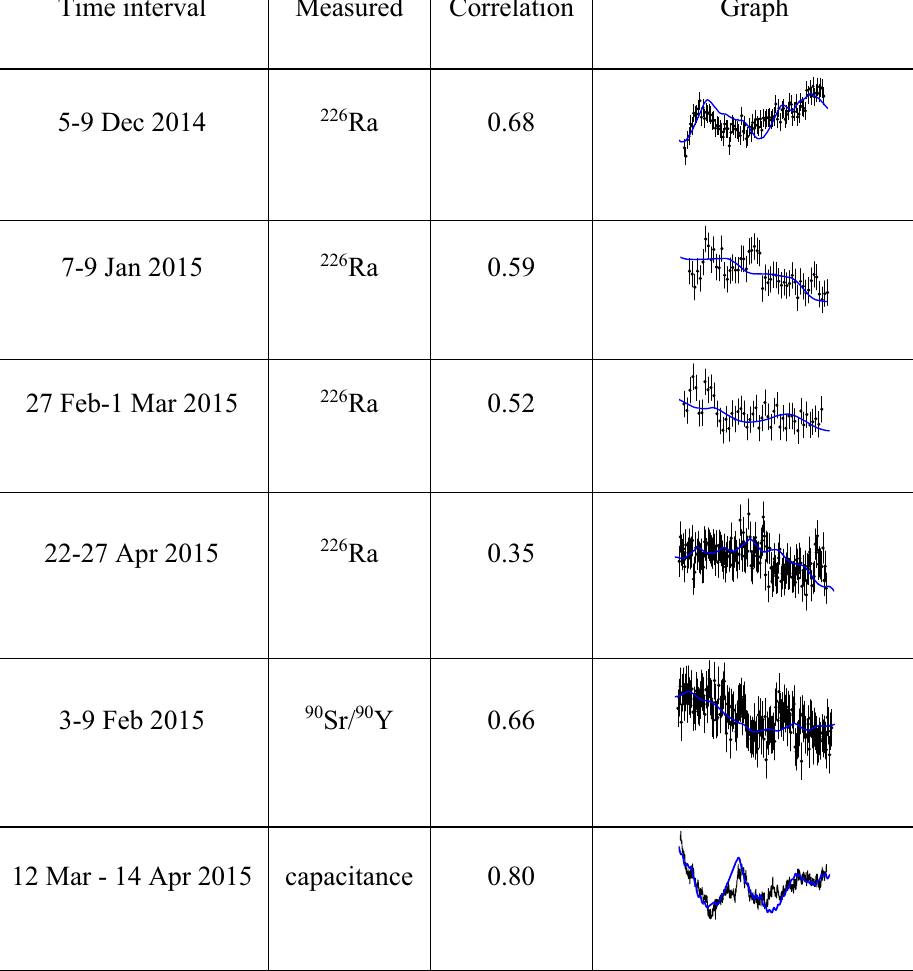
Figure 2. Six examples of decay rate/capacitance measurements compared to the humidity model 16